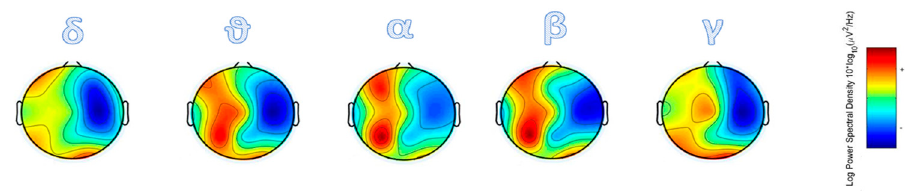
Figure 2. The resting state EEG (collected at T0), in which a large spectral peak in the θ band was found.